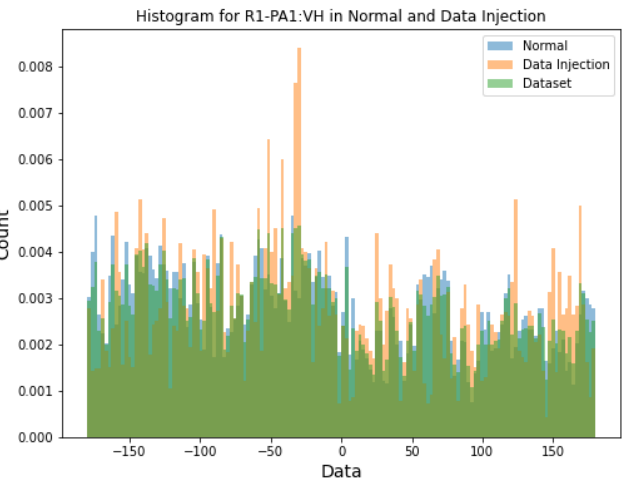
Figure 2. Histogram comparison of normal, injection, and all dataset events for R1-PA1:VH .